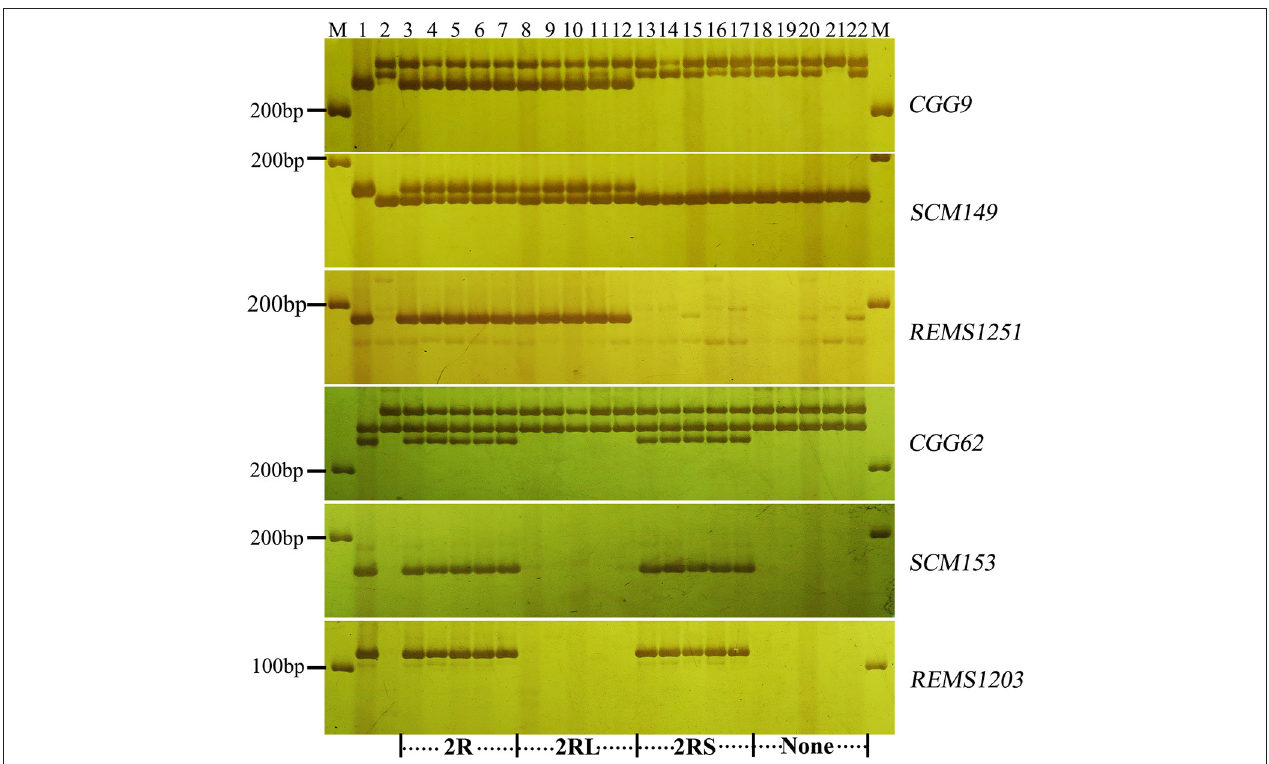
FIGURE 3 | Marker analysis of BC 2 F 2 plants segregating for 2R using rye-specific markers ( CGG9 , SCM149 , and REMS1251 ) on the long arm of 2R chromosome and markers ( CGG62 , SCM153 , and REMS1203 ) on the short arm of 2R chromosome. Ten plants (lane 3–12) resistant to powdery mildew at the seedling stage and 10 susceptible plants (lane 13–22) were analyzed. Lane 3–7 and 18–22 show plants with entire 2R and without 2R chromosome, respectively. Lane 8–12 and 13–17 signify the presence of 2RL and 2RS alone, respectively. Lane 1 and lane 2 signify the resistant parent (Sorento) and susceptible parent (Xuezao),